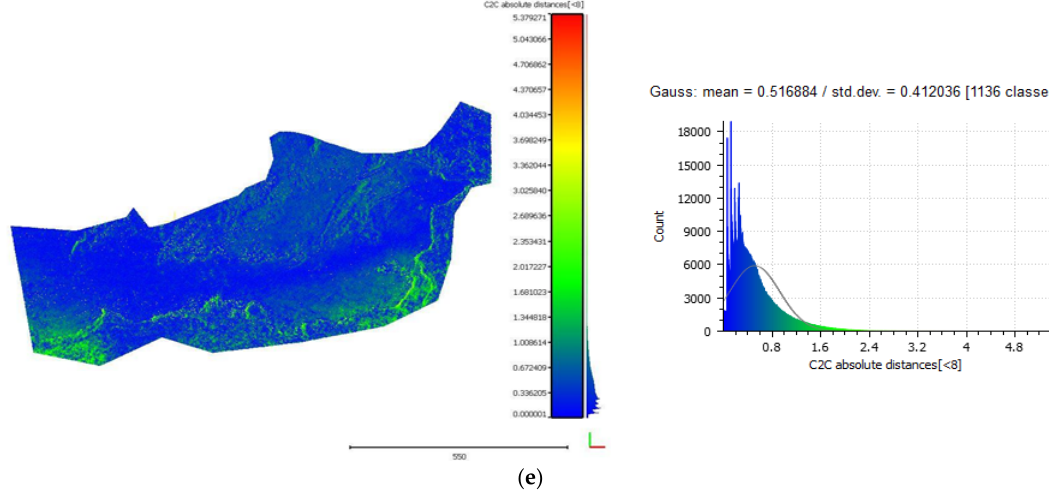
Figure 18. The cloud ‐ to ‐ cloud distances between the LiDAR point cloud and the point clouds that resulted from each iteration of the algorithm on the Agia Napa test site. Row ( a ) presents the cloud ‐ to ‐ cloud distances between the LiDAR point cloud and the initial point cloud from the uncorrected photos while rows ( b – e ) present the cloud ‐ to ‐ cloud distances between the LiDAR point cloud and the point cloud that resulted from the first, second, third and fourth iteration of the algorithm respectively. Residuals of 3rd and 4th iterations are similar (below the ground pixel size), hence there is no significant improvement after the 3rd iteration.